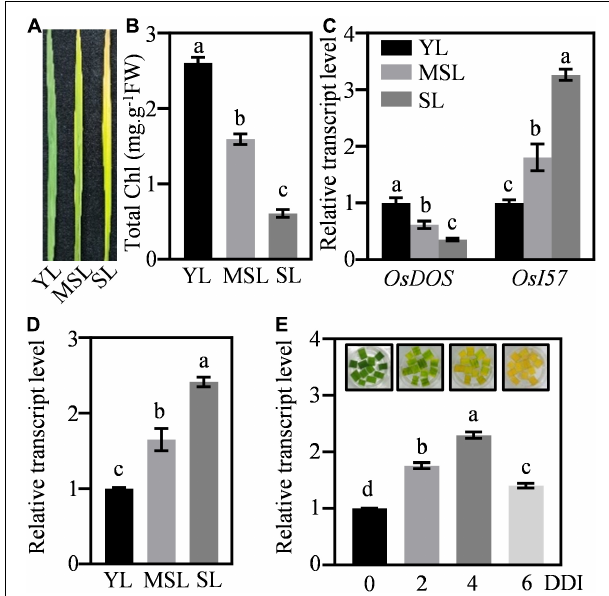
FIGURE 2 | OsWRKY53 promotes dark-induced senescence. (A) The appearance of rice leaves at different developmental stages. YL, young leaf. MSL, moderately senesced leaf. SL, senesced leaf. (B) Chlorophyll content in rice leaves at different developmental stages. (C) Transcript levels of senescence-related genes, namely, OsDOS and OsI57, in rice leaves at different developmental stages. (D) Transcript levels of OsWRKY53 in rice leaves at different developmental stages. (E) Transcript levels of OsWRKY53 in detached rice leaves during dark-induced senescence. DDI, day of dark incubation. The different letters above each bar indicate statistically significant differences determined by one-way ANOVA followed by Tukey’s multiple test ( p <